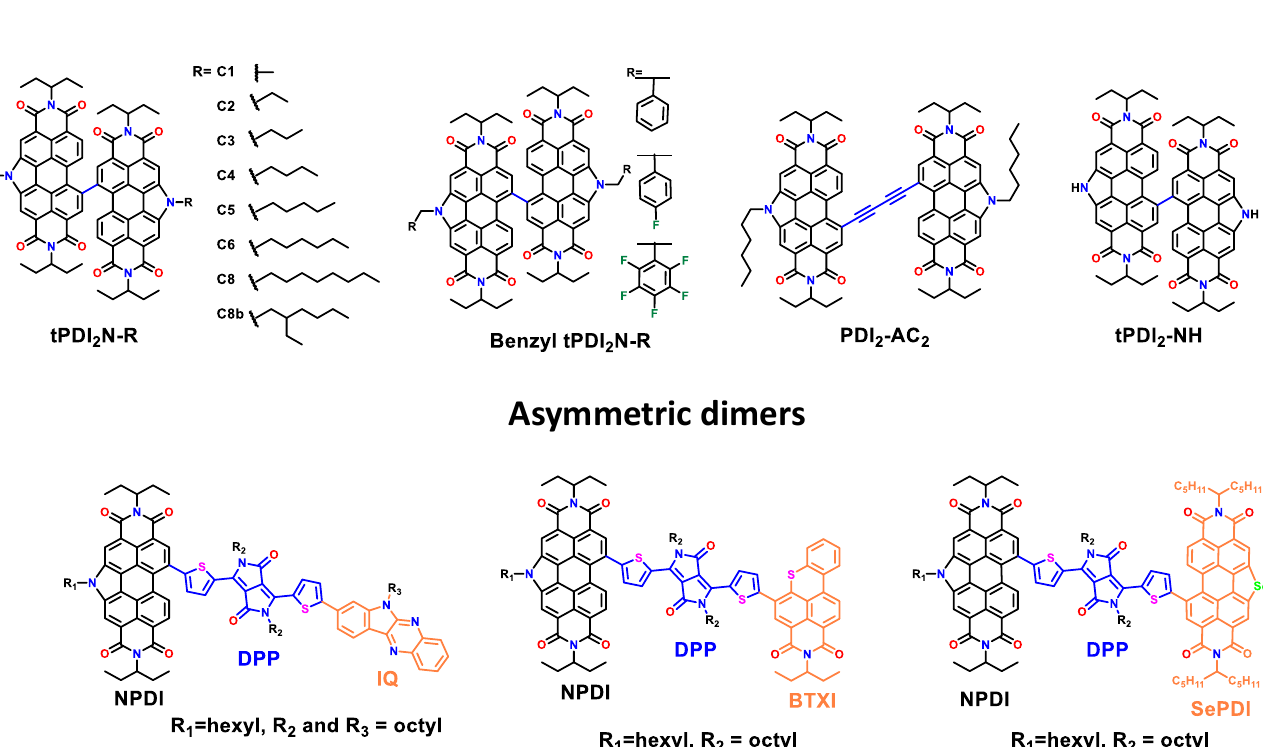
Figure 4. Chemical structures of N-annulated PDI-based materials introduced by our research team, used as NFAs in OPV devices and covered in this review.